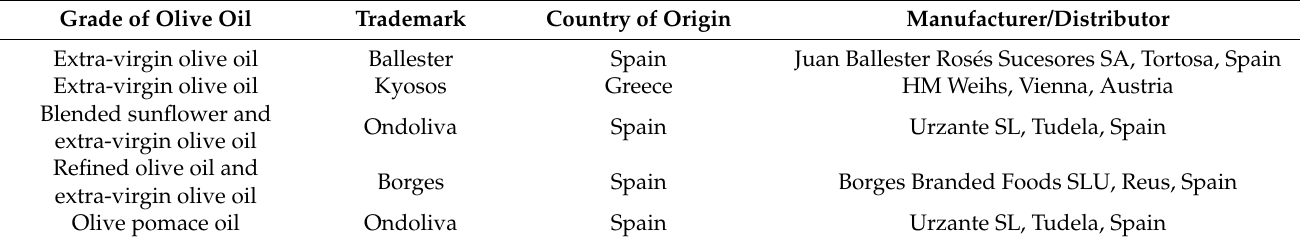
Table 4. List of oil